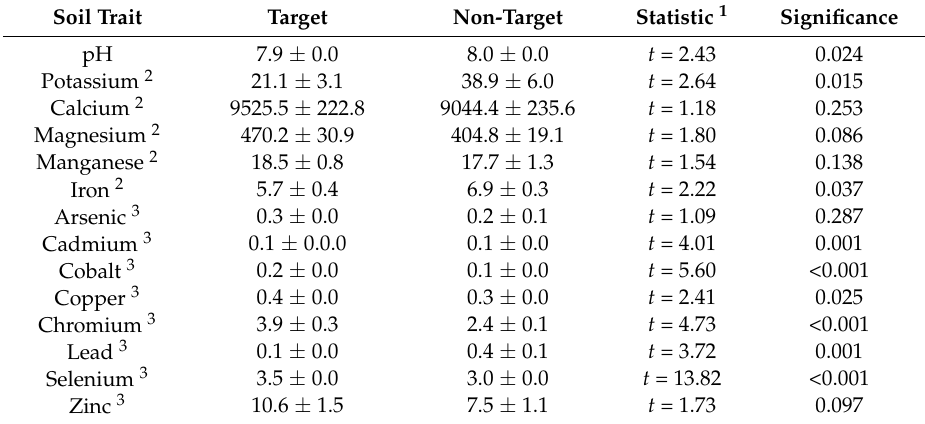
Table 4. The influence of proximity to Cycas micronesica trees on soil chemical traits in Shioya sand soils on Rota. Target soils were collected underneath cycad trees. Non-target soils were collected 5-m from focal cycad trees. Means ± SE, n = 12.